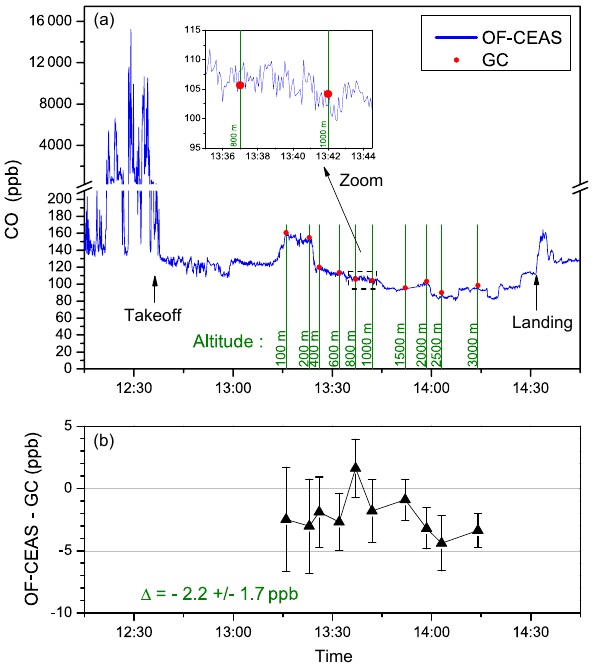
Figure 3. (a) CO airborne measurements by OF-CEAS in real time and by GC with latter flask analysis at the LSCE. Altitudes are in- dicated during collection sample for GC measurements. OF-CEAS data are averaged for 5.5s. (b) Difference between OF-CEAS and GC measurements, where OF-CEAS values are computed in dry air and averaged for 1min around the flask filling times. Error bars in this graph indicate the standard deviation of OF-CEAS measure- ments for 1min around the comparison time. The difference of OF- CEAS and GC measurements has a mean value of − 2.2ppb with a standard deviation of